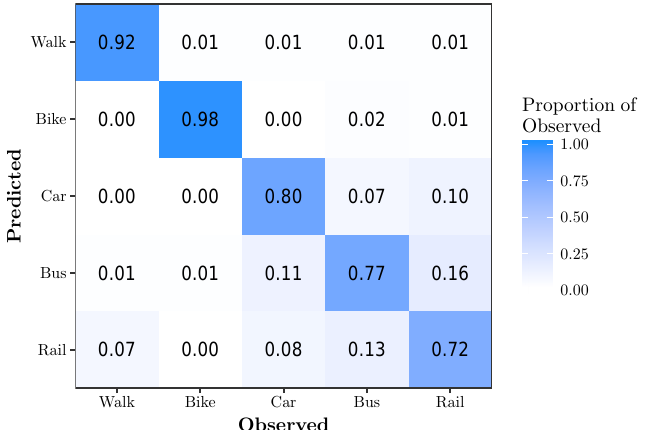
Figure 4. Confusion matrix for PCA- k NN{3}. This model has an overall accuracy of 83.5% using 68.8% of the original feature variation.